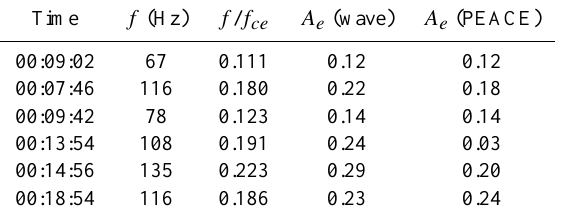
Table 3. The electron temperature anisotropy estimated from the frequencies of 6 lion roar events occurring on 16 March 2004, and measured by PEACE near the same